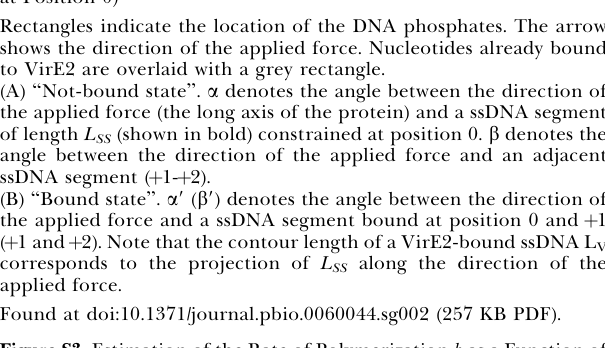
Figure S4. Analysis of Individual Binding Events at High Force (A) Force-feedback experiment at ; 50 pN in the presence of VirE2 with lengths in nanometers (similar to Figure 1A). Inset: Trace between 340 and 420 nm length reduction, where steps from single or multiple VirE2 binding events are visible (space between arrows indicate the binding of 3 proteins, i.e., ; 10 nm). Length increase steps also occur and correspond to the unbinding of one or several monomers. (B) Top: Probability density function (PDF, solid red line) calculated from the complete trace in (A). The probability density function (PDF) was determined by summing individual normal distributions with mean x i and variance r 2 (where x i denotes the experimentally measured filament length and r ¼ 2.2 nm for our apparatus) [36]. The distances between peaks (gray lines) are multiples of 3.35 nm (i.e., the ssDNA compaction produced by one VirE2 molecule on 19 nucleotides). This is shown in Figure S3 (bottom) with the PDF from 340 to 420 nm. Coloured bars indicate how many elementary compression steps occur in between each peak. Given the ssDNA base-to-base distance at ; 50 pN (0.57 nm; Figure S5) and the number of nucleotides bound per VirE2 monomer (19) [18], we found L V to be ; 0.395 nm (i.e ., 0.57 – (3.35/19). This value is in good agreement with that determined by EM (0.41 nm), assuming the ssDNA to lie concentrically within the helical protein filament. The result shown here is a first attempt to determine the base-to-base distance of VirE2-bound-ssDNA from single-molecule experiment. We empha- size that such experiments are extremely challenging due to the difficulty of keeping a fragile ssDNA molecule in flow at high tension for a few minutes. Figure S5. Optical Tweezers Force Curves of DNA Typical force versus extension curves of dsDNA (green), and ssDNA (red) in assembly buffer (50 mM NaH 2 PO 4 pH 8.0, 150 mM NaCl and 5% w/v glycerol). Curves are normalized to the contour length of ssDNA (assuming a base-to-base distance of 0.7 nm). The DNA base- to-base distance (obtained by multiplying the normalized extension by 0.7 nm) projected onto the direction of the applied force is shown at the top [16,20]. Found at doi:10.1371/journal.pbio.0060044.sg005 (321 KB PDF). Figure S6. Distance-Clamp Experiment Trace Experimental time trace of a single ssDNA molecule upon VirE2 injection obtained in a distance-feedback optical tweezers operation mode. The distance is set at 0.14 normalized extension, correspond- ing to the normalized extension of ssDNA when a VirE2 helix is formed. The change in force measured upon injection of VirE2 proteins (up to ; 50 pN) is in good agreement with the values obtained from standard force versus elongation curves at an extension of 0.14 where no feedback is applied (Figure 3A). Found at doi:10.1371/journal.pbio.0060044.sg006 (319 KB PDF). Figure S7. Gel Shift Assay Showing the Cooperative Binding Mode of VirE2 on ssDNA Gel retardation analysis of reactions between a ; 170-bases-long ssDNA and VirE2. Radioactive ssDNA was incubated with VirE2 for 1 h and analyzed on a native 4% acrylamide gel. The fast migrating bands at the bottom represent the free ssDNA. Upon binding of VirE2, large nucleoprotein complexes formed, migrated slower and hence localized at the top of the gel. The binding of the proteins to ssDNA was cooperative, as hardly any intermediate ssDNA–protein complexes were detected. Found at doi:10.1371/journal.pbio.0060044.sg007 (1 MB PDF). Text S1. The Experimental and Theoretical Determination of the Polymerization Rate and the Mechanics of DNA-VirE2 Nucleoprotein Filaments Found at doi:10.1371/journal.pbio.0060044.sd001 (97 kB